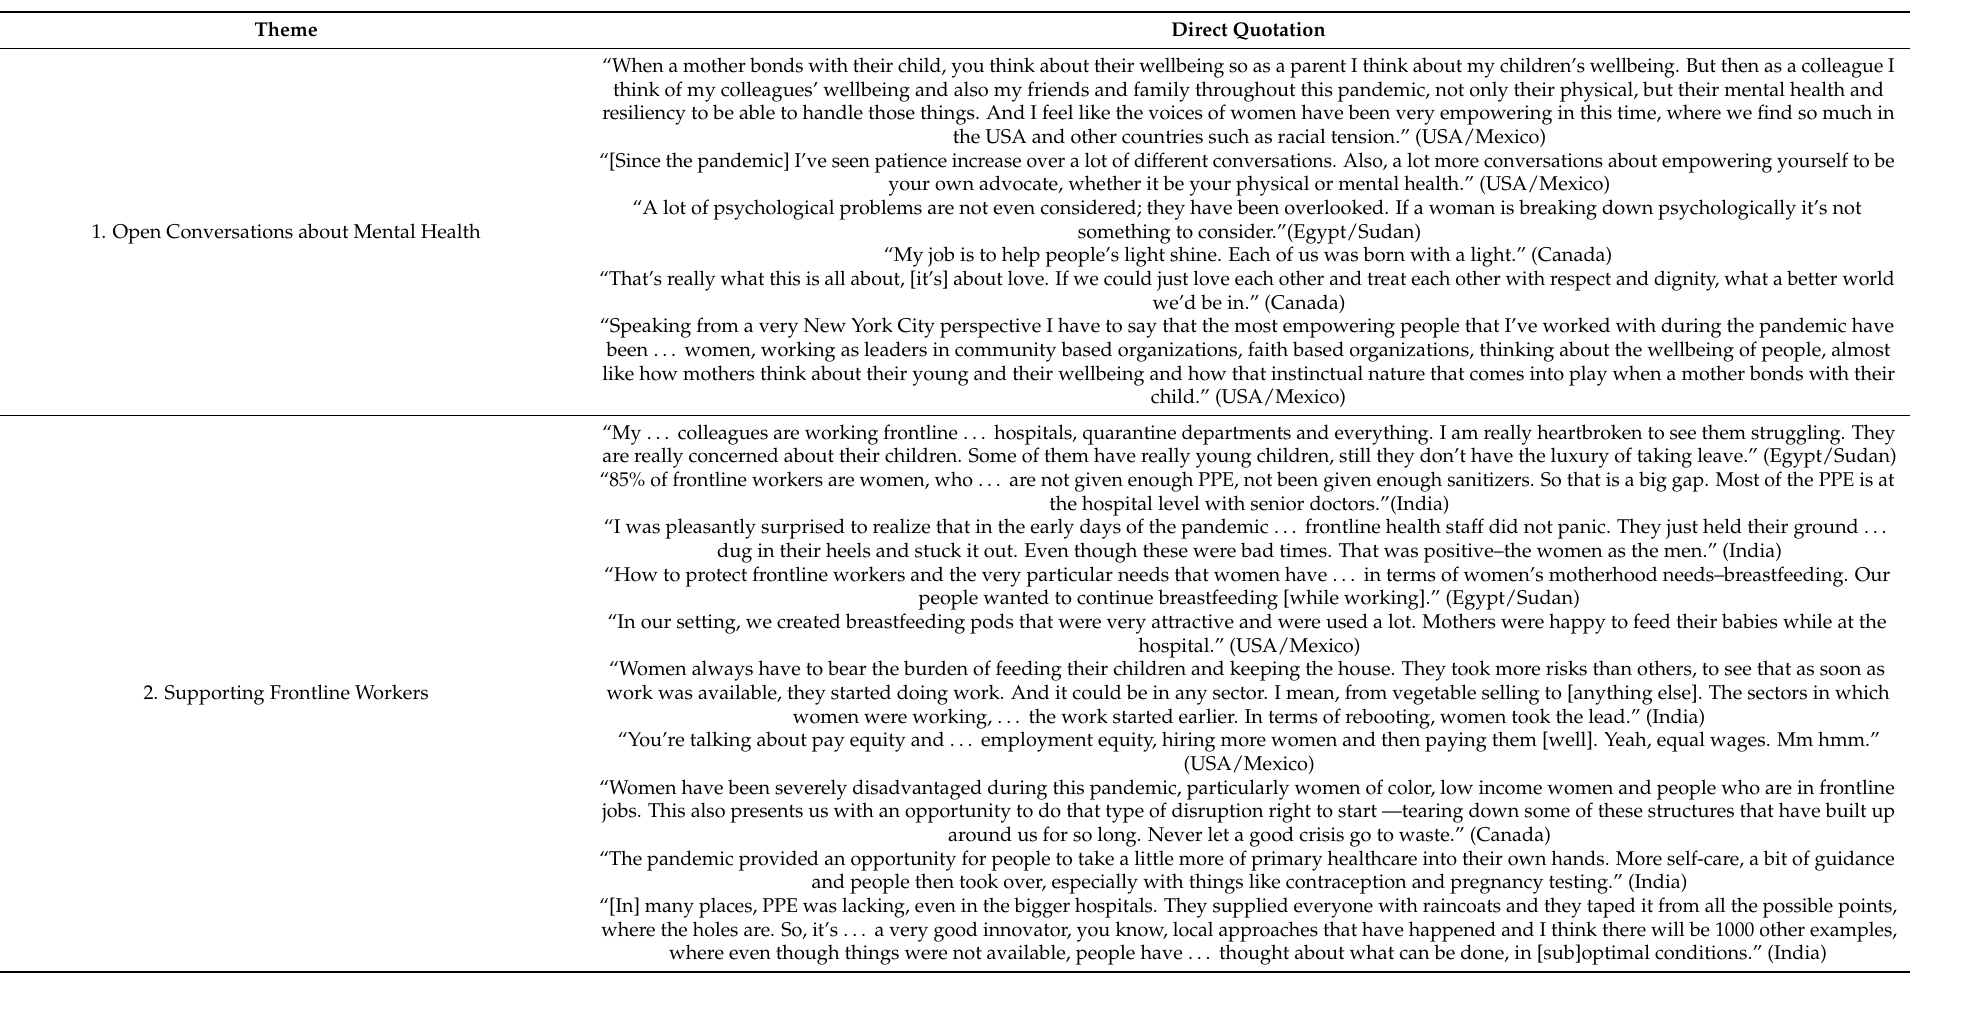
Table 2. A summary of the themes with corresponding direct quotations from the focus group